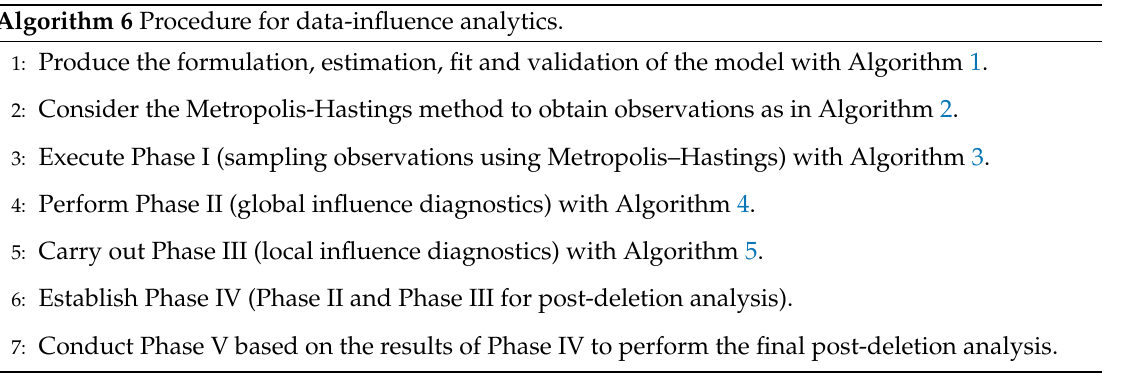
Algorithm 6 Procedure for data-influence